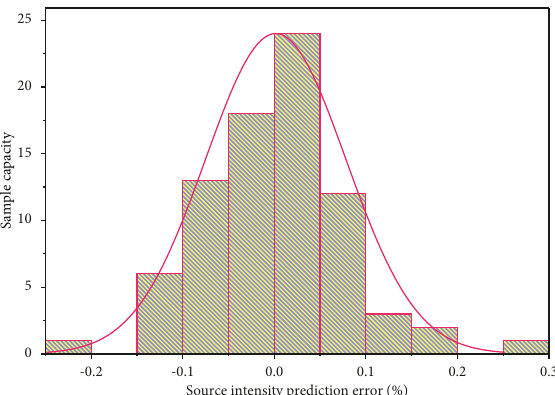
Figure 8: Error distribution of vibration source intensity predicted using BPNN.